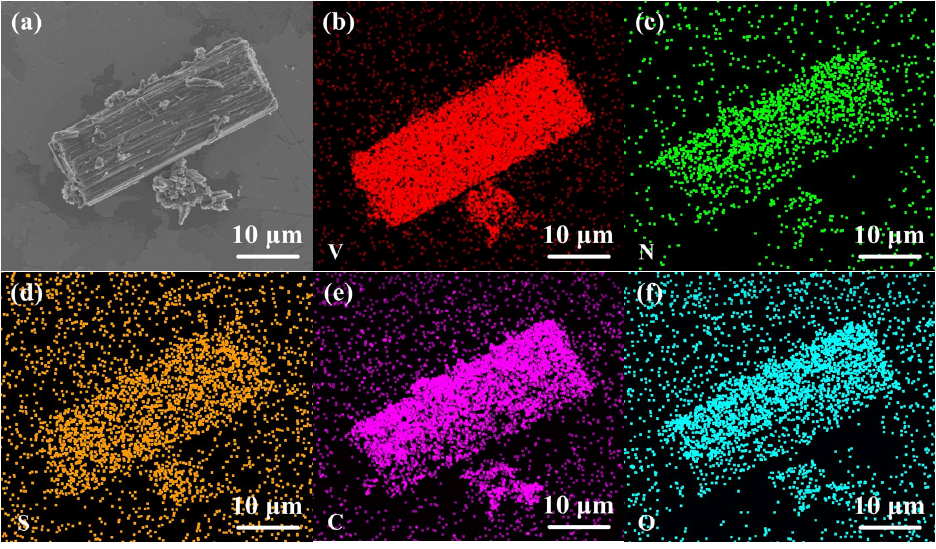
Figure 4. ( a ) SEM image and ( b – f ) elemental mapping images of VN/S@PANI